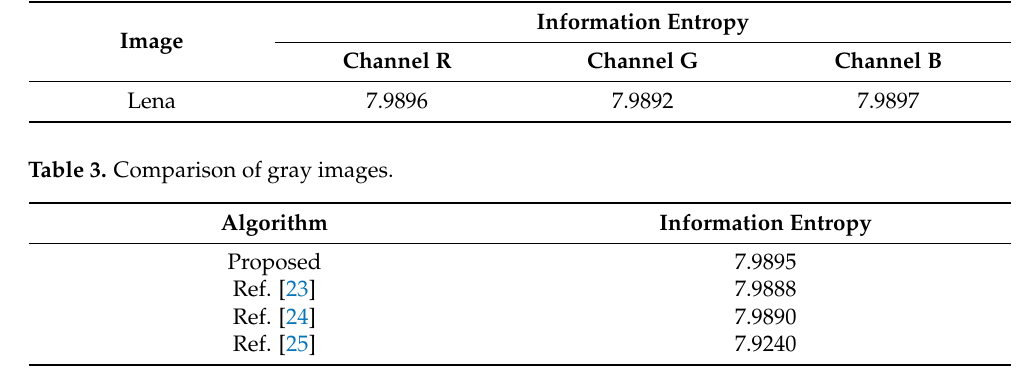
Table 3. Information entropy test.